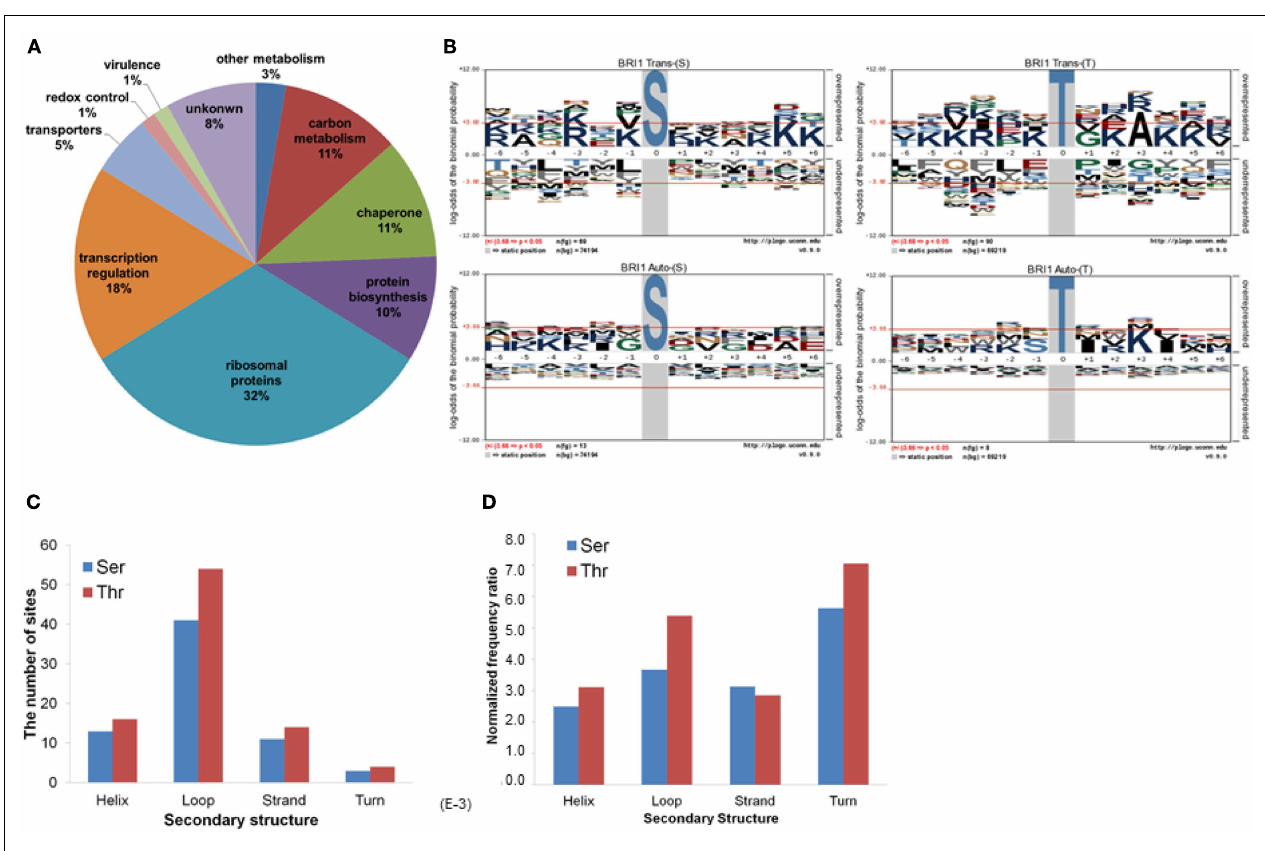
respectively. Residues above the x -axis are overrepresented, relative to their statistical significance in the context of the entire E. coli proteome, while residues below the x -axis are underrepresented.The red line corresponds to a p -value of 0.05. (C) The distribution of the BRI1 transphosphorylation sites in protein secondary structure. (D) The distribution of BRI1 transphosphorylation sites normalized for the total number of serine or threonine residues in a given secondary structure in the E. coli